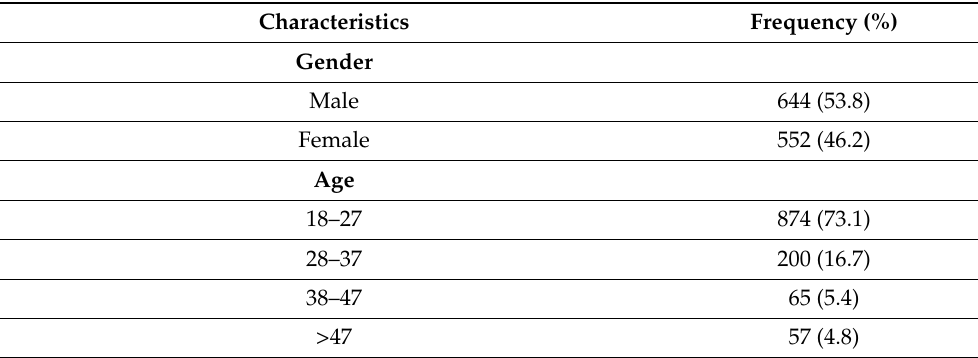
Table 1. Sociodemographic characteristics of participants and status of COVID-19 test and